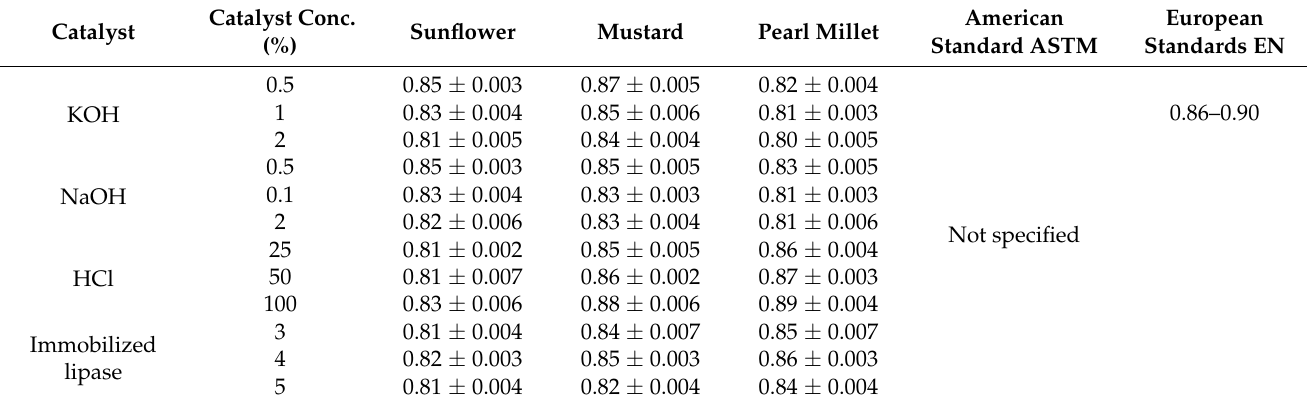
Table 1. Density (kg/L) of biodiesel from sunflower, mustard, and pearl millet seed oils. Catalyst Conc. Catalyst